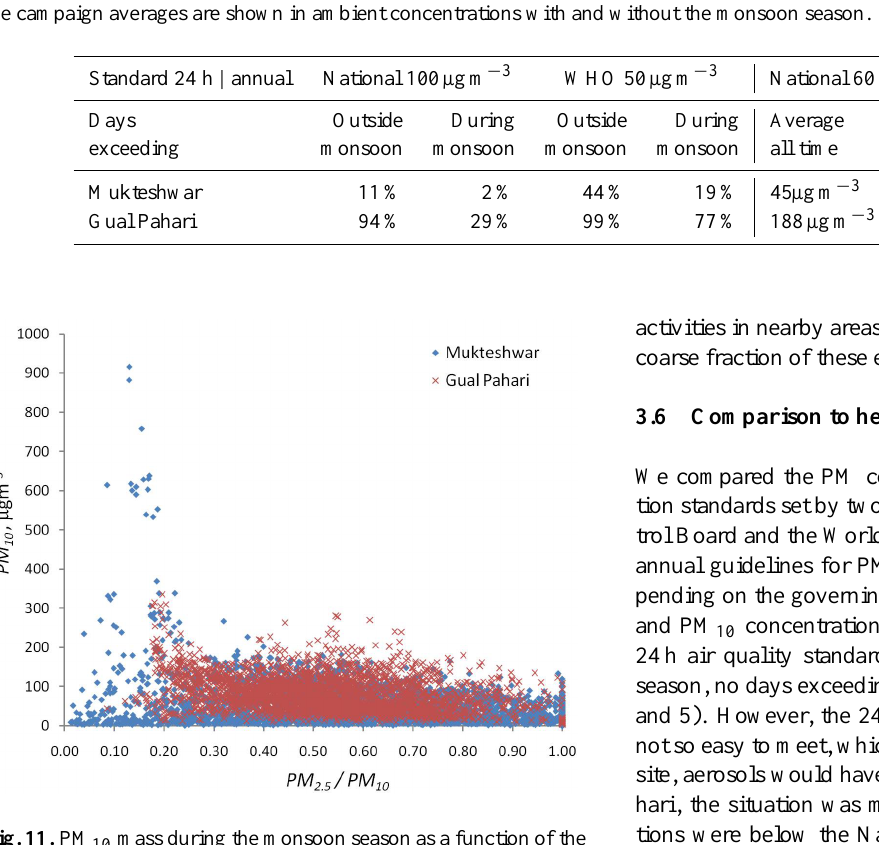
Fig. 11. PM 10 mass during the monsoon season as a function of the PM 2 . 5 /PM 10 ratio. Concentrations are in STP